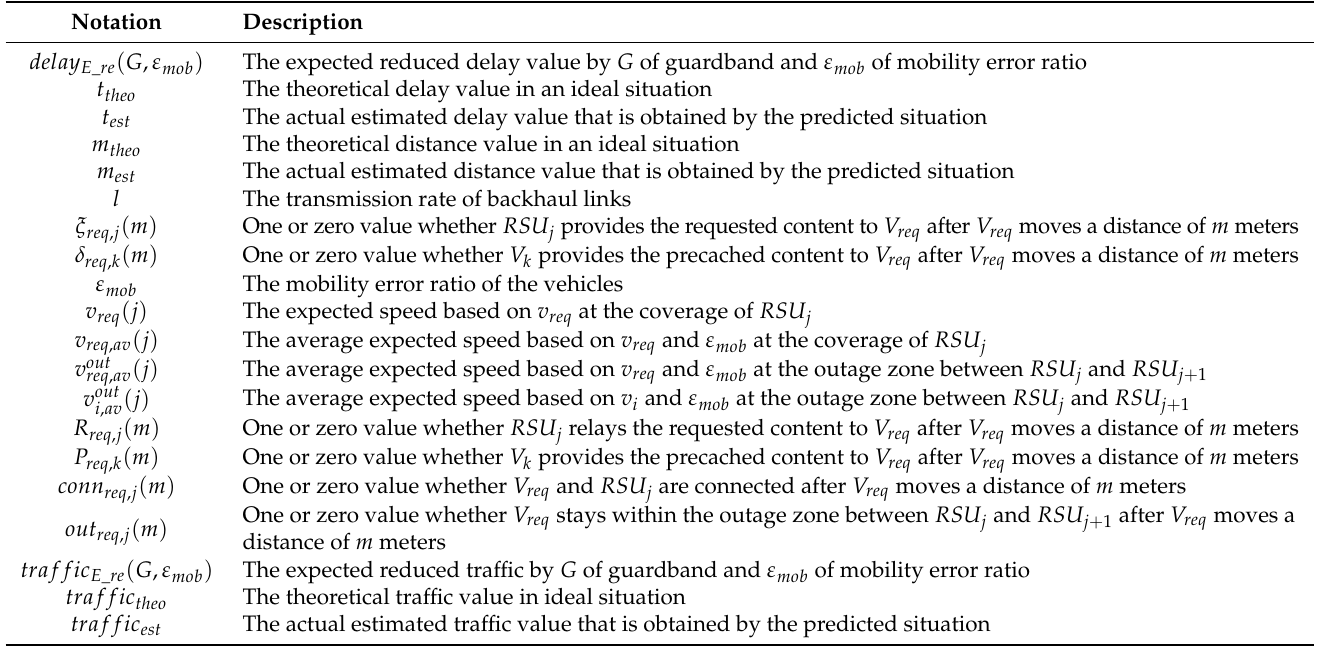
Table 2. Notations for the calculation of the